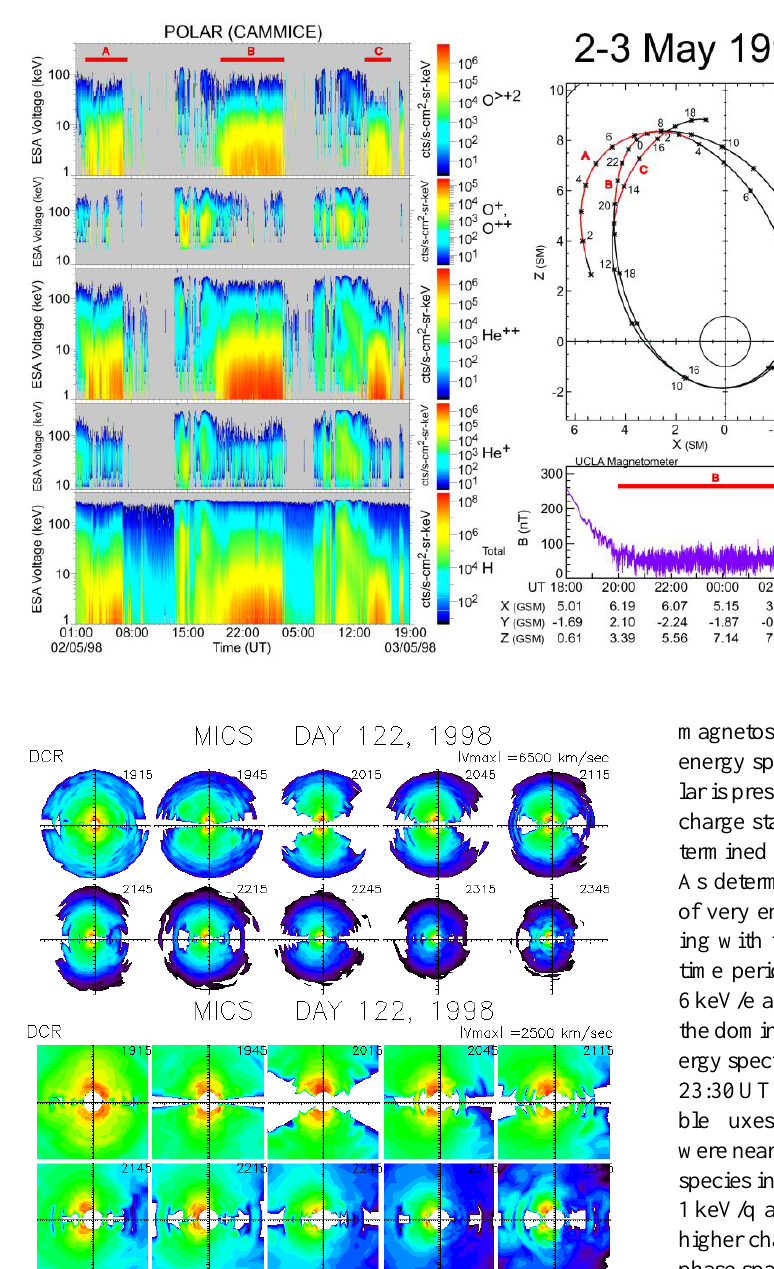
Fig. 5. The phase space distribution at all energies as a function of the parallel and perpendicular particle velocities in the top portion of the panel and the same distribution at lower energies in the bot- tom panel determined using the double coincidence response [DCR] of the Polar MICS